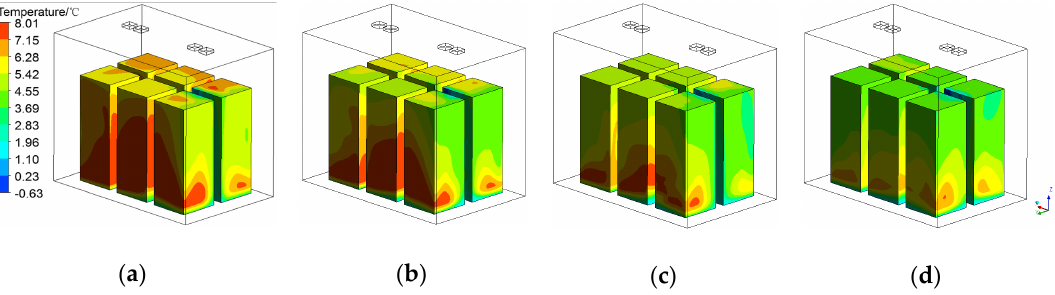
Figure 9. Temperature distribution with different velocity levels: ( a ) 4 m/s; ( b ) 8 m/s; ( c ) 12 m/s; and ( d ) 16 m/s. Table 3. Analysis results of different parameters.